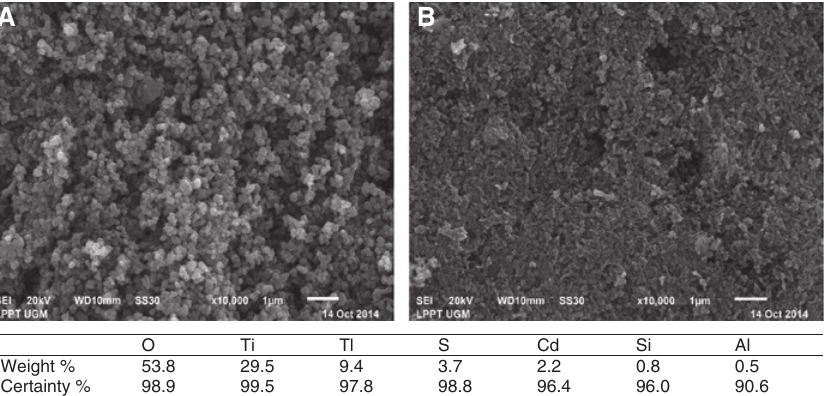
/G and (B) CdS-TiO 2